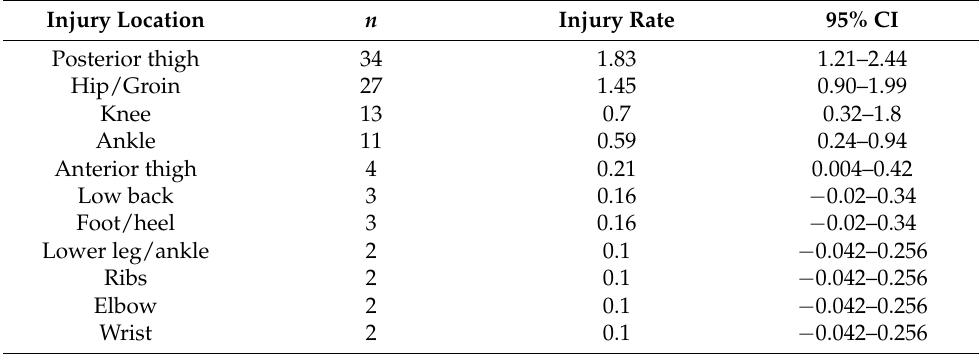
Table 1. Number of injuries, injury rate (number of injuries per 1000 h of exposure), and 95% confidence intervals (CI) according to anatomical location.